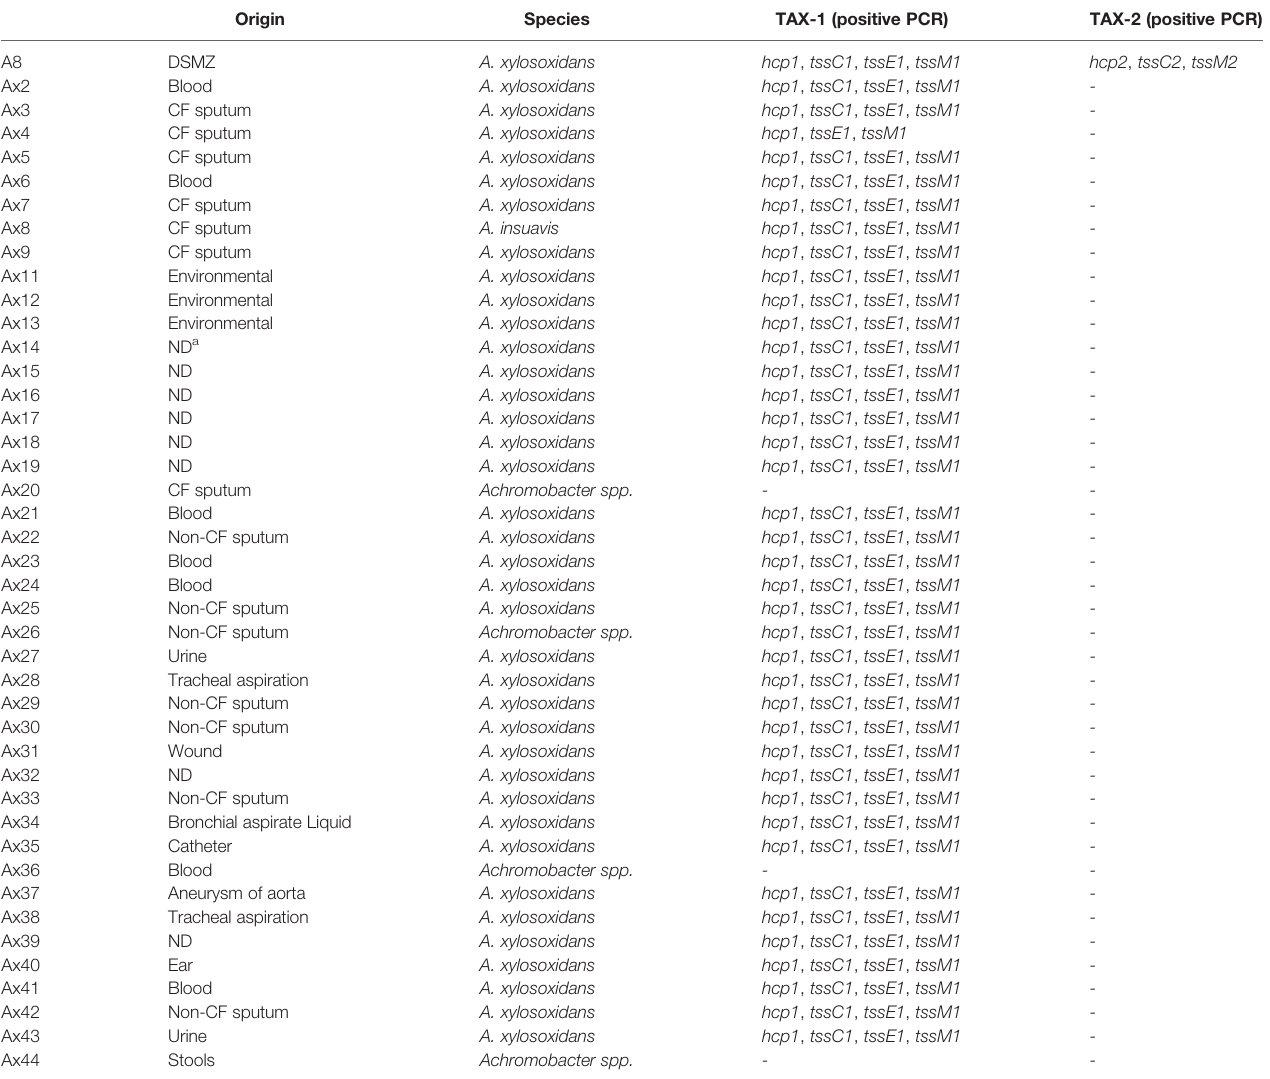
TABLE 1 | Genomic survey of T6SS distribution in A. xylosoxidans clinical isolates and clinical characteristics.